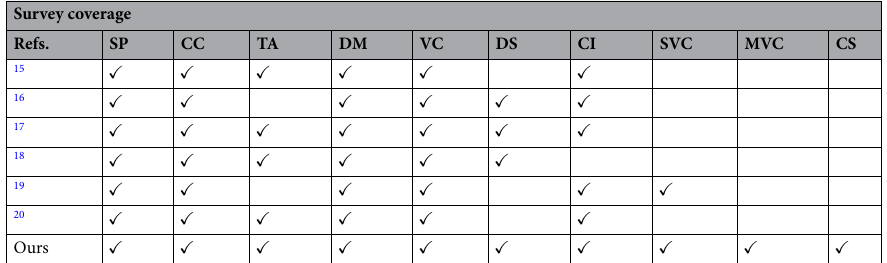
Survey coverage